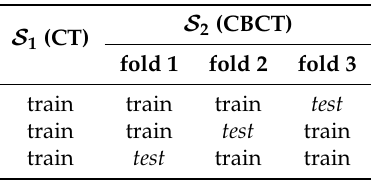
Table 1. Three-fold cross-validation. To train the model, we used n CT CT scans from S 1 and the n CBCT first volumes from the CBCT folds labeled “train.” To test the model, we used all 21 volumes from the CBCT fold labeled